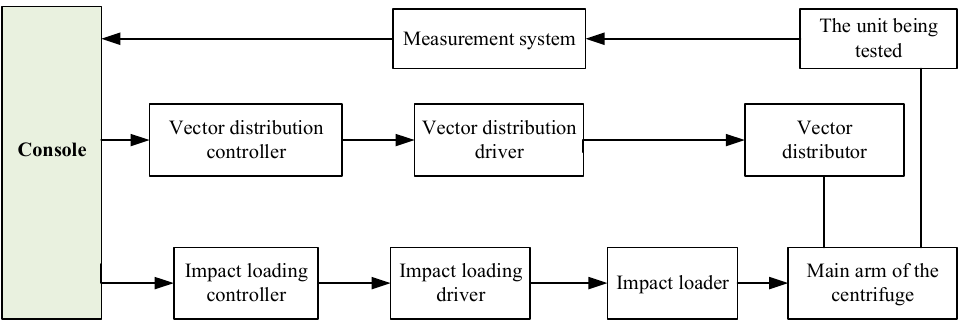
Figure 1. Air-cannon-started compound centrifugal turntable simulation test system.